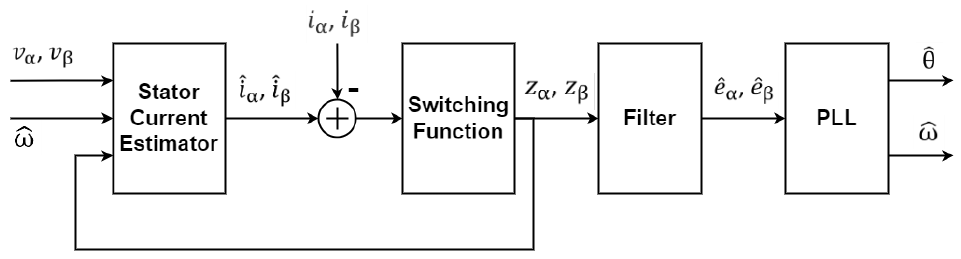
Figure 6. Basic SMO scheme.